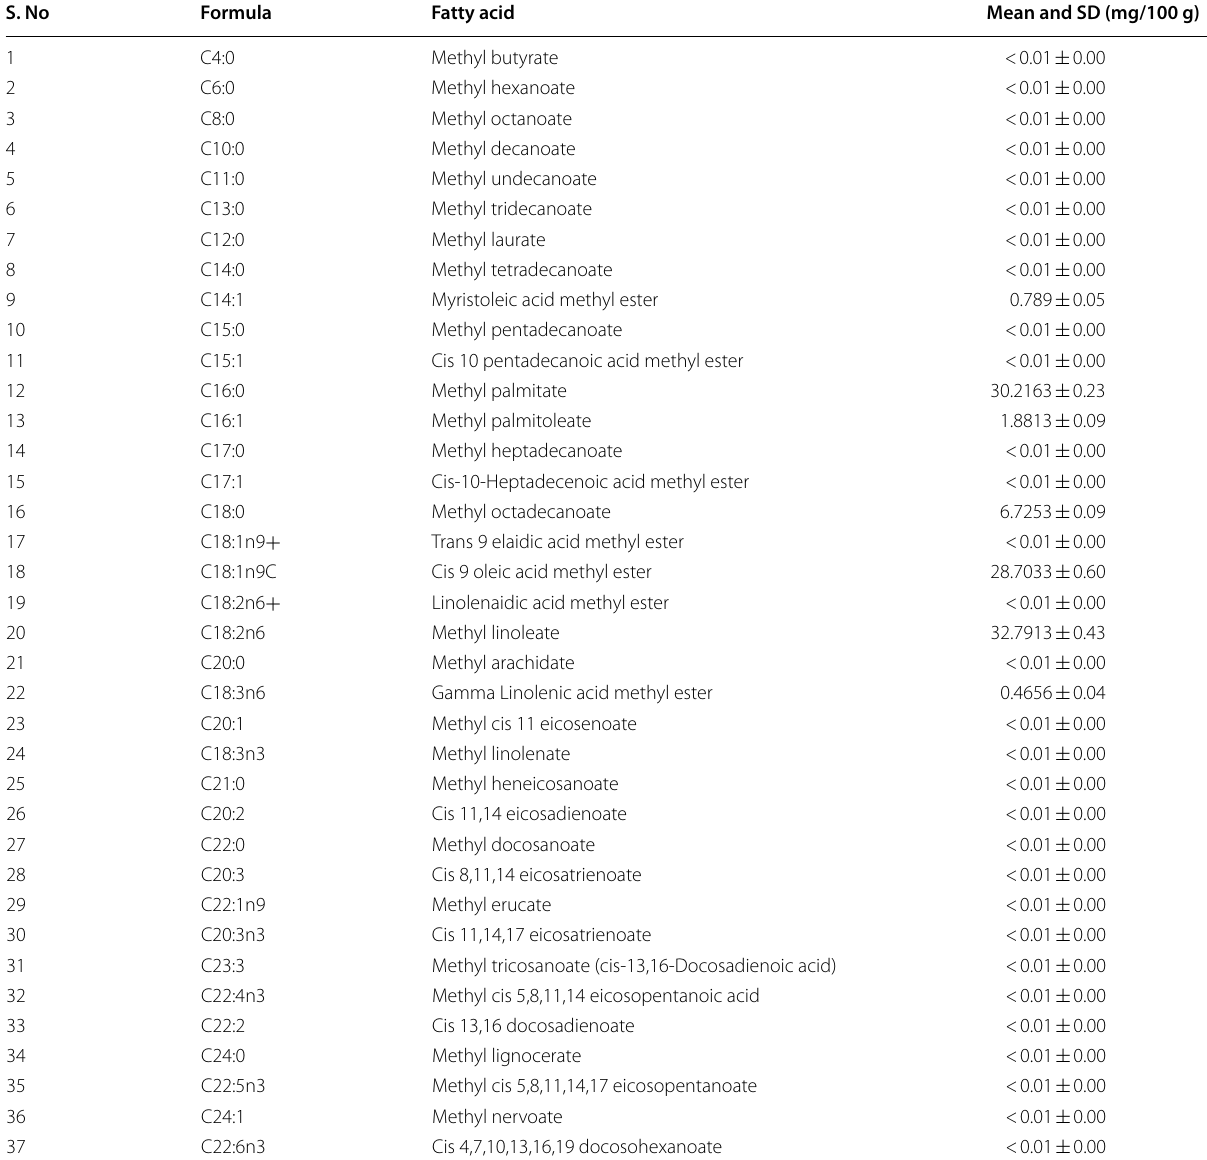
Table 6 Fatty acid contents of Coiblemmus